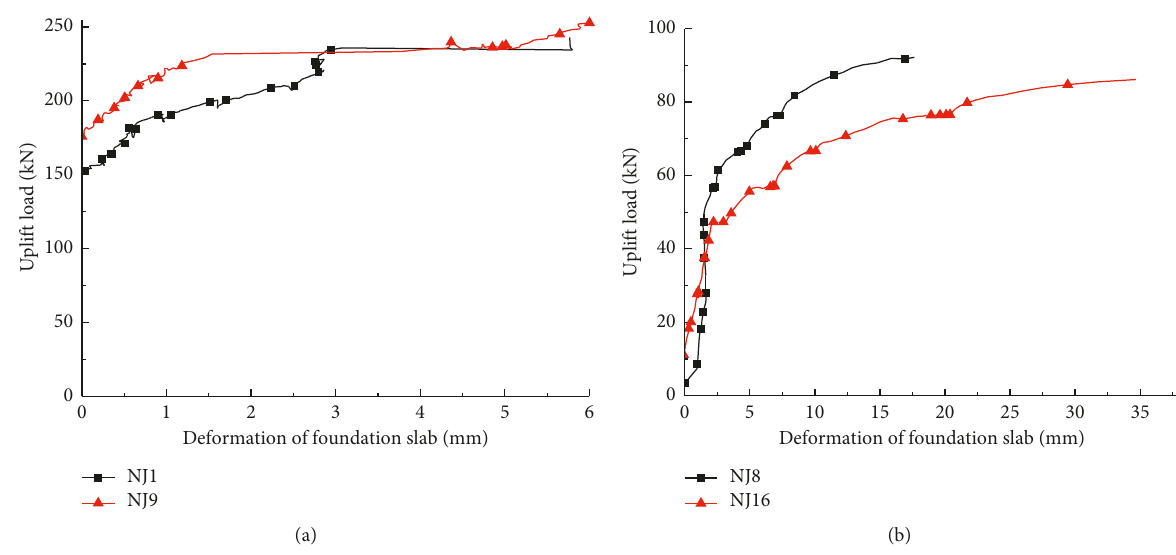
Figure 8: Typical load-deformation curve for the test specimens. (a) NJ1(NJ9). (b) NJ8(NJ16).